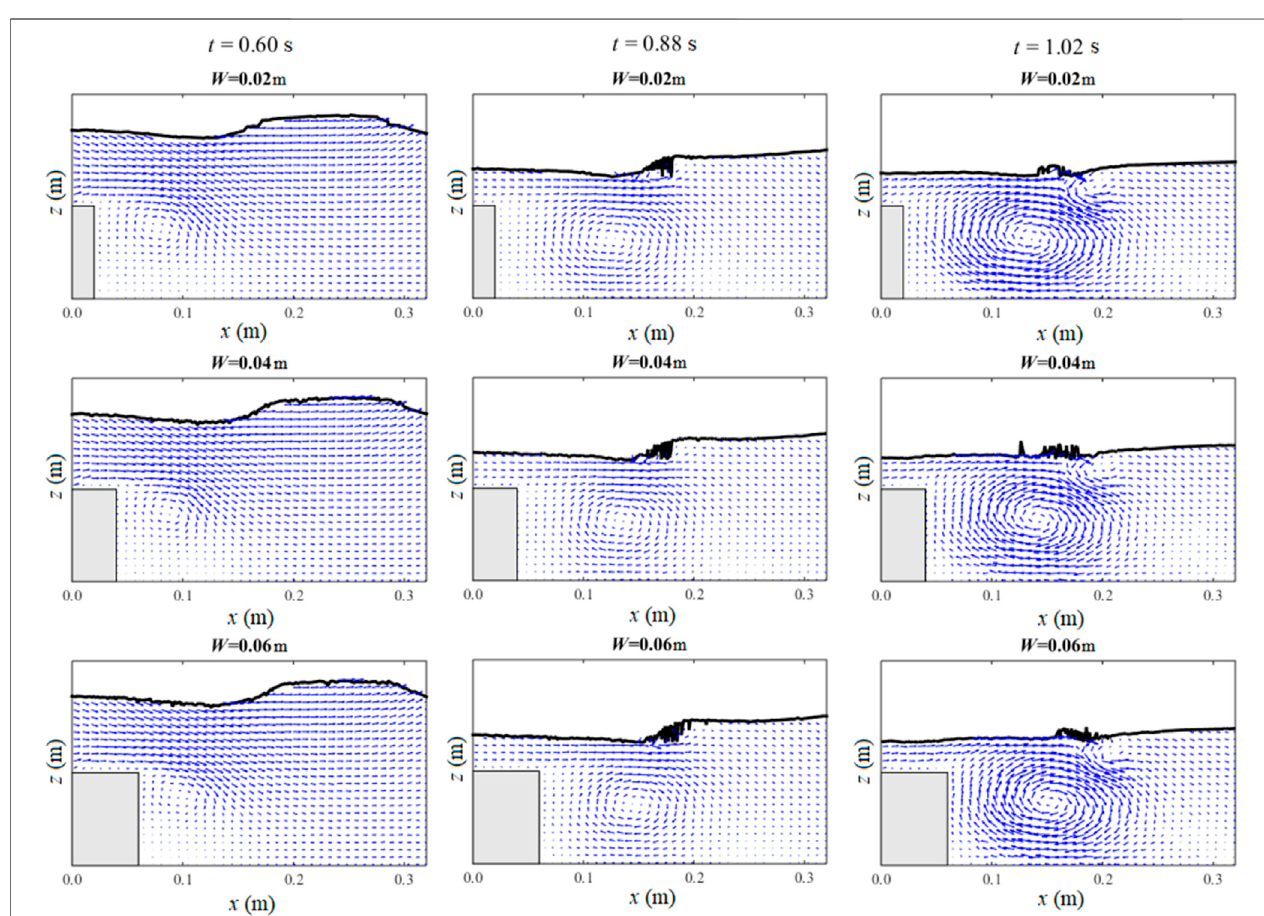
FIGURE 9 | Comparisons of calculated velocity vector fi elds for different horizontal widths of the barrier.